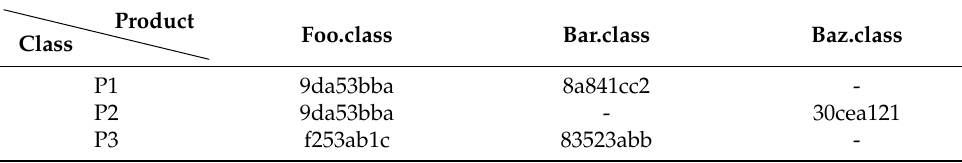
Table 1. An example of checksum matrix.